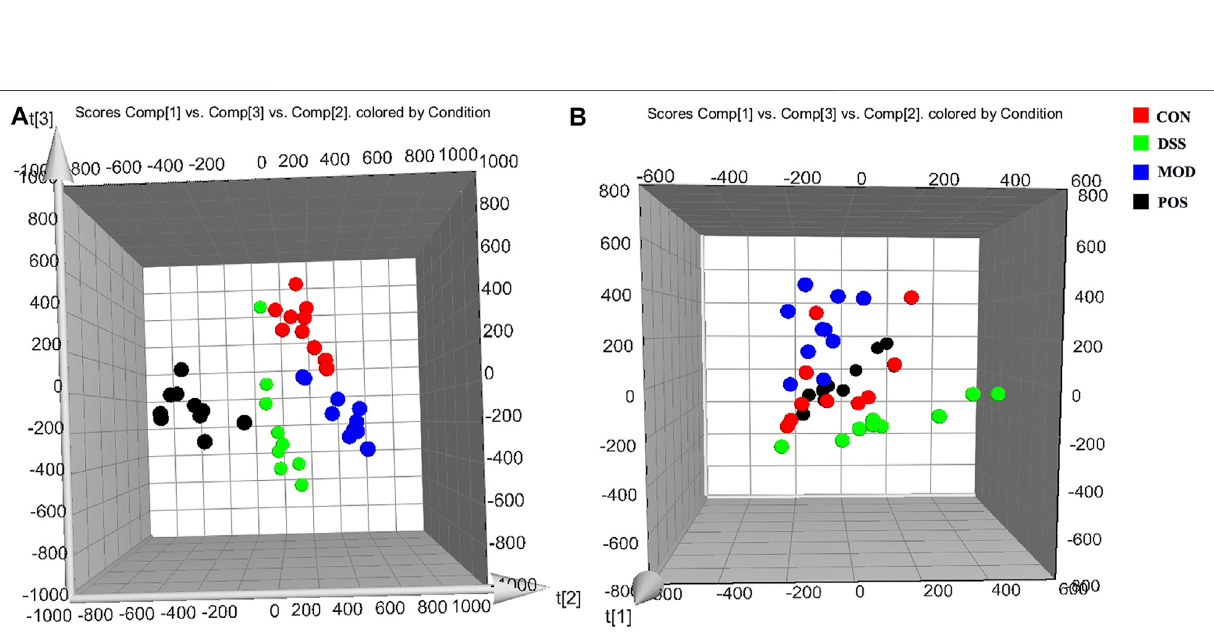
FIGURE 1 | Effect of DSS intervention on PD based on general characteristics, behavioral manifestations, biochemical levels, and pathological changes. (A) Body weight, (B) writhing times, (C) latent period of writhing response, (D) uterine index, (E) biochemical parameters in serum (E 2 , ET, and Prog), and uterine (PGE 2 , PGF 2 α , and β -EP), (F) representative micrographs of uterine histopathology at magni fi cation ×100. Data are presented as the mean ± SD; * p < 0.05, ** p < 0.01 vs. CON group, # p < 0.05, and ## p < 0.01 vs. MOD group.